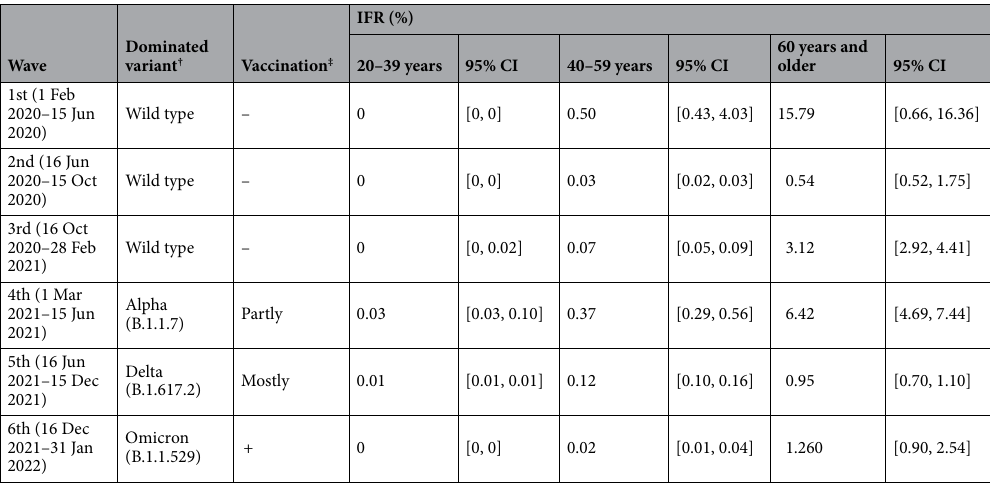
Table 3. Estimated infection fatality risk (IFR) of COVID-19 in Osaka, Japan, 2020–2022. CI confidence interval (using bootstrap method). † The variant of concern that occupied the largest quota in the genome survey during the corresponding wave. ‡ Qualitative description of the progress of vaccination